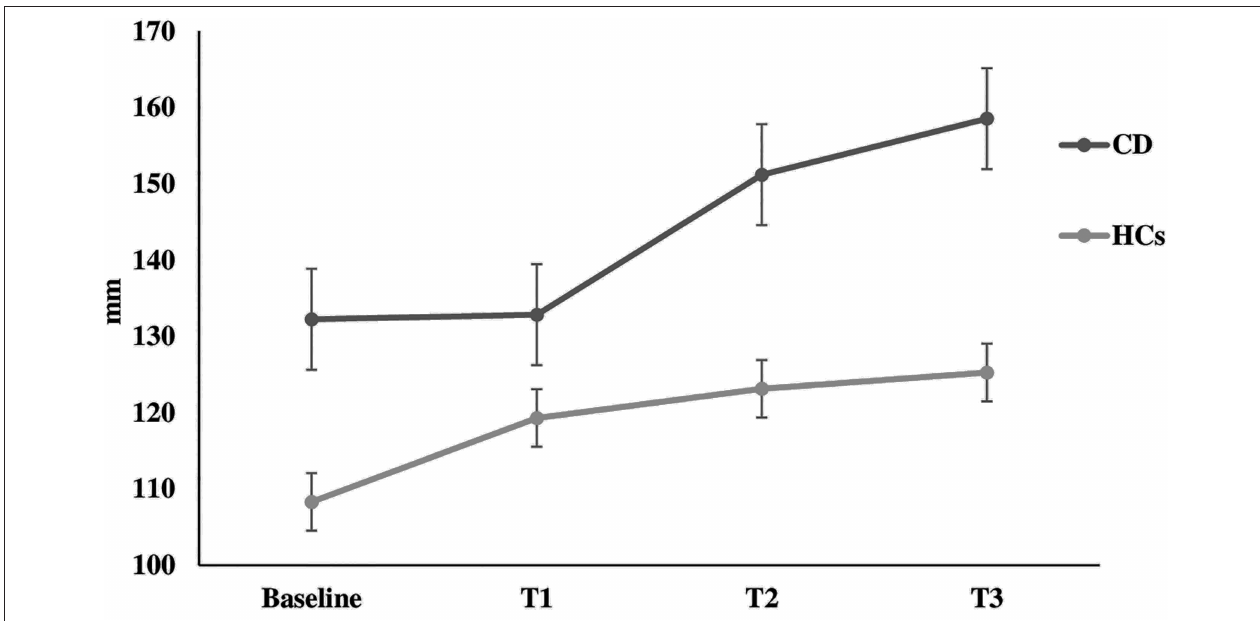
FIGURE 1 | Sway length. Sway length at rest (baseline) and during the execution of all Stroop test trials (T1, T2, T3) in healthy controls and in patients with cervical dystonia. HCs healthy controls; CD cervical dystonia; mm millimeter.